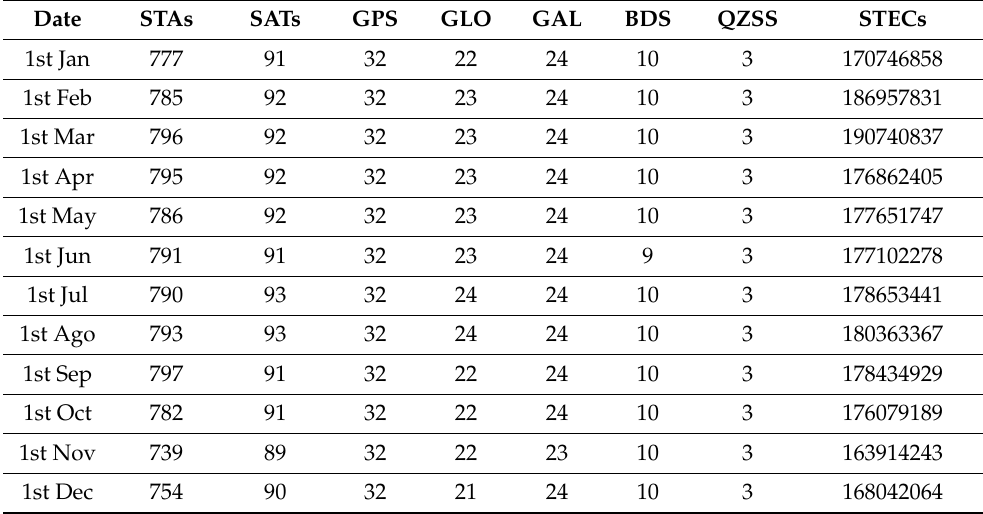
Table 1. Number of stations, satellites (indicating to which constellation they belong to), and STECs processed per day during